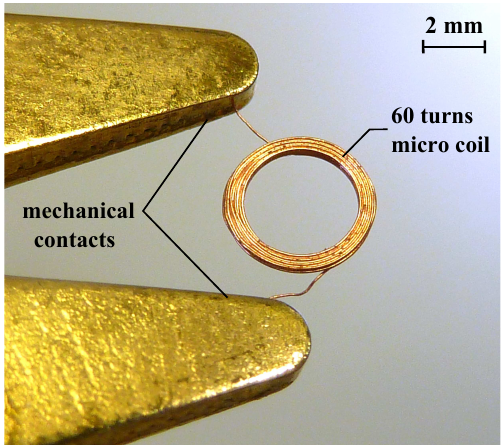
Figure 1. Ohmic contact based wired measurement of a micro